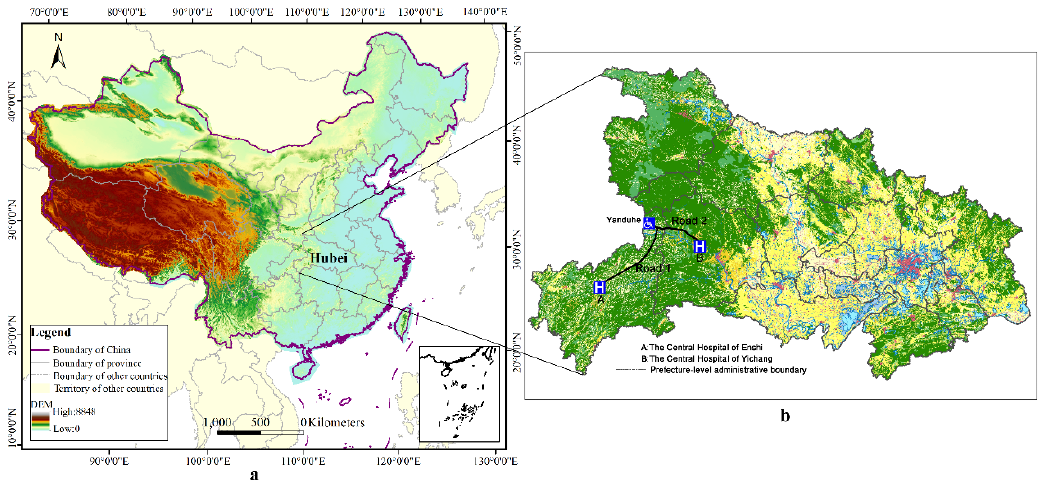
Figure 1. The location of Hubei Province in China ( a ), and one example of transborder medical seeking behavior that leads to reimbursement inconvenience ( b ).